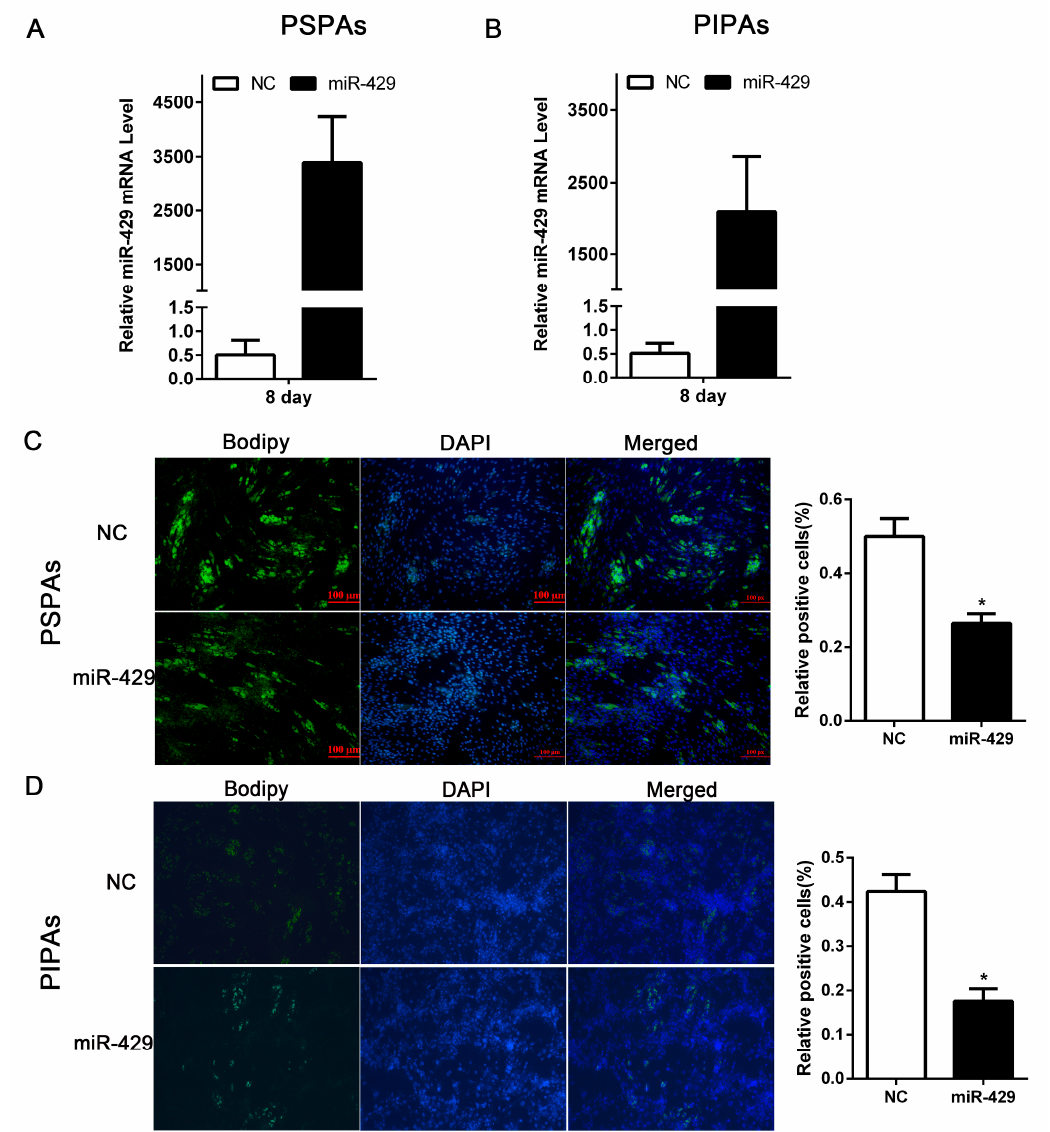
Figure 2. Overexpression of miR-429 inhibit the lipid droplets accumulation in PSPAs and PIPAs. miR-429 agomir or NC was transfected into PSPAs and PIPAs when the density reaching 80%. 24 h later, DMI induce cells differentiation. RT-qPCR was performed on day 8 of adipogenic differentiation to estimate miR-429 overexpression efficiency in ( A ) PSPAs and ( B ) PIPAs. On day 8 of differentiation, PSPAs ( C ) and PIPAs ( D ) cellular lipid droplets were stained with bodipy (green) and cell nuclei were stained with DAPI (blue) (bar size = 100 µm). Statistical results are indicated as means ± SEM; n = 3; * p < 0.05. NC, negative control; miR-429, miR-429 agomir; DAPI, 4 ′ ,6-diamidino-2-phenylindole.